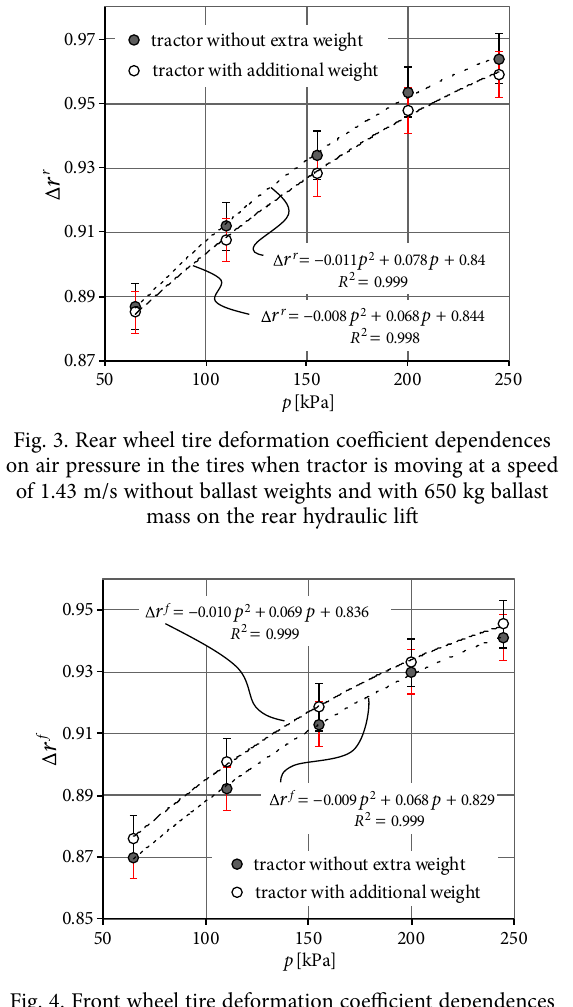
Fig. 4. Front wheel tire deformation coefficient dependences on air pressure in the tires when tractor is moving at a speed of 1.43 m/s without ballast weights and with 650 kg ballast mass on the rear hydraulic